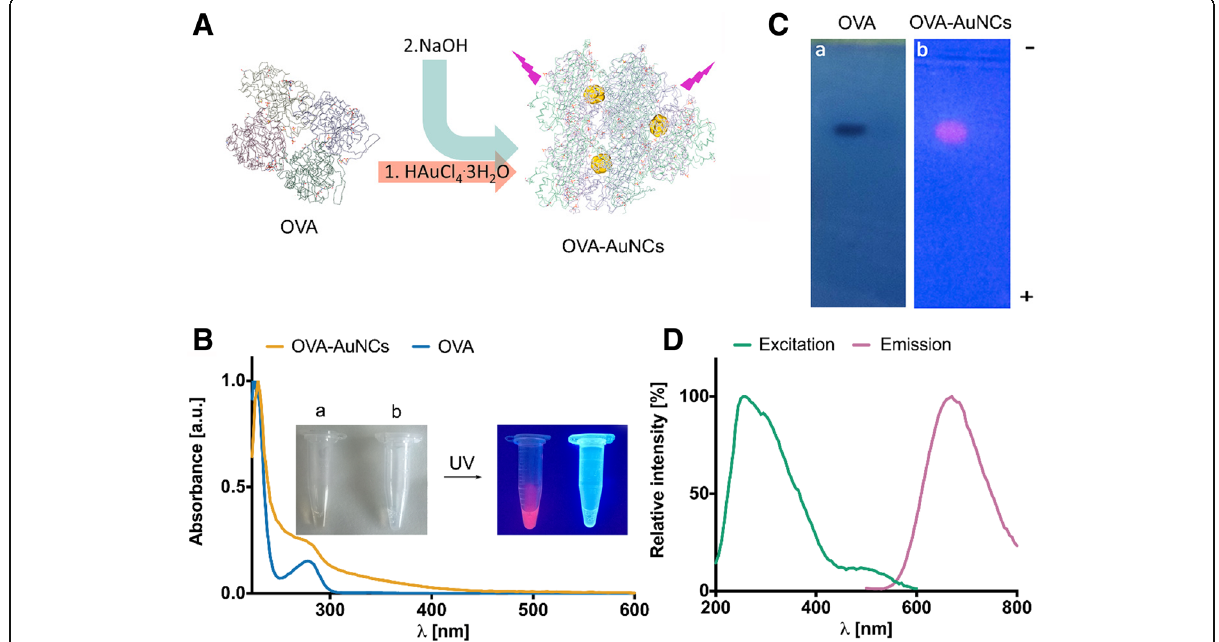
Fig. 1 a Schematic representation of OVA-AuNCs synthesis. b UV-visible spectra of OVA (blue line) and OVA-AuNCs (orange line). Insert: images of OVA-AuNCs ( a ) and OVA ( b ) under visible light illumination (left) and under UV light illumination (365 nm) (right). c Agarose gel electrophoresis of OVA (stained with Coomassie Blue G-250) and OVA-AuNCs (under UV light illumination). d Fluorescence excitation (green line) and emission (pink line) spectra of